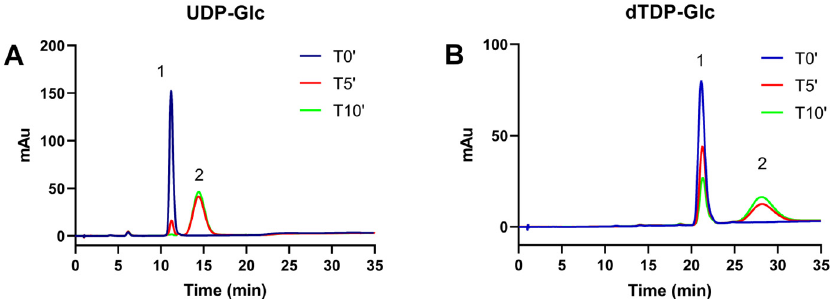
Figure 2. Anion-exchange HPLC analysis of TvUGD products. Incubations were performed in identical conditions at 25 ◦ C using 0.3 mM substrates; samples were withdrawn at different time points and analyzed by anion-exchange chromatography. The progressive formation of new peaks was observed for both UDP-D-Glc (Panel ( A )) and dTDP-D-Glc (Panel ( B )). The complete conversion of UDP-D-Glc to the product was completed in less than 10 min, whereas dTDP-D-Glc was still present at that time, indicating a lower activity of the enzyme for this substrate. Peak 1: substrate, NDP-D-glucose. Peak 2: product,